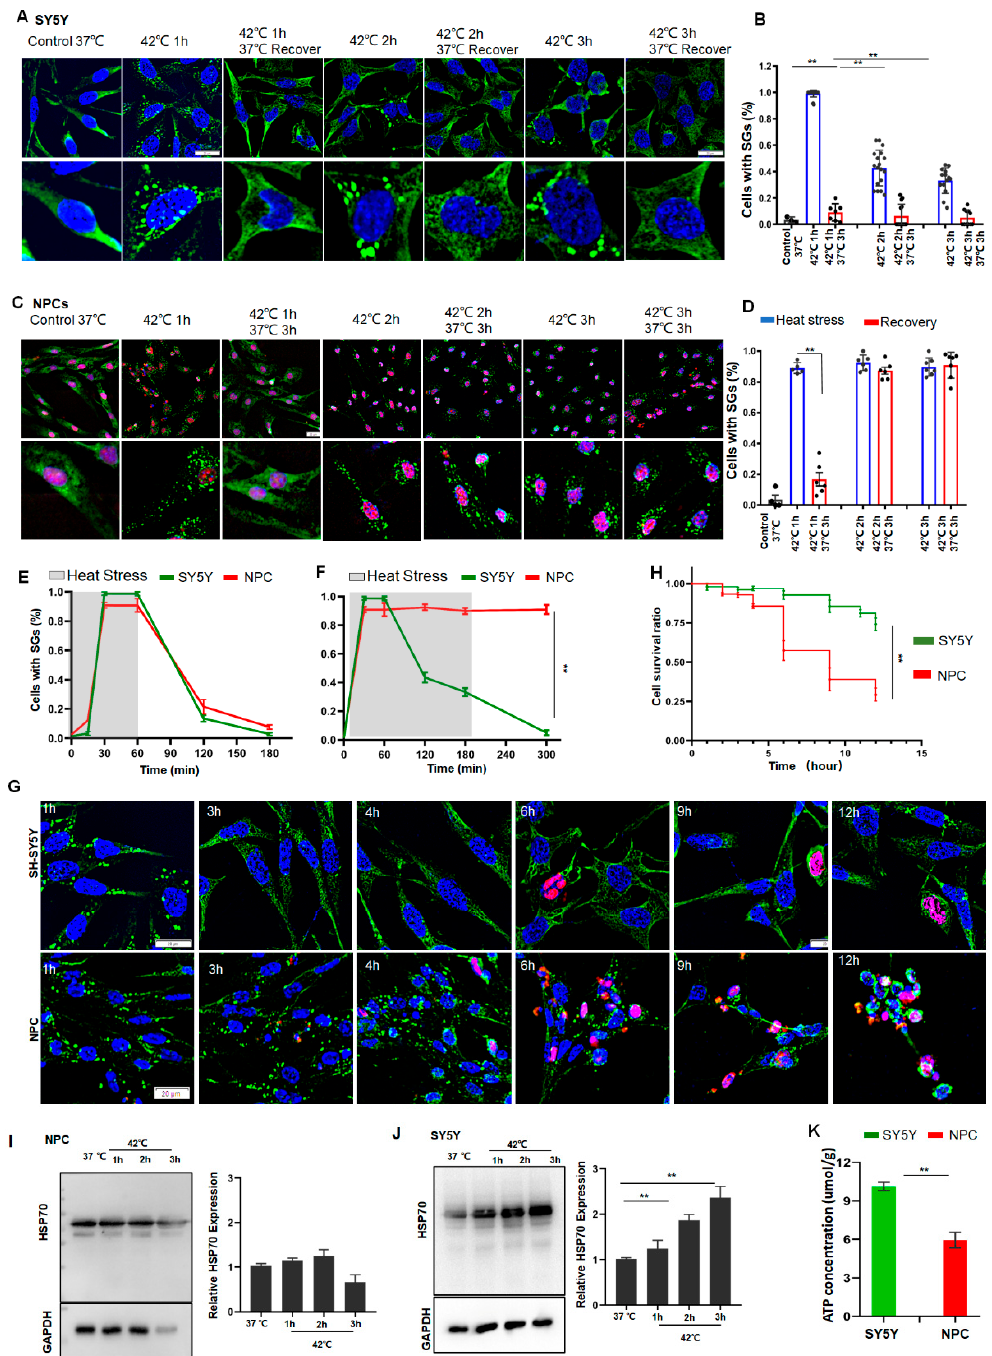
Figure 3. SY5Y cells resolved SGs but NPCs failed to do so due to low levels of HSP70 and